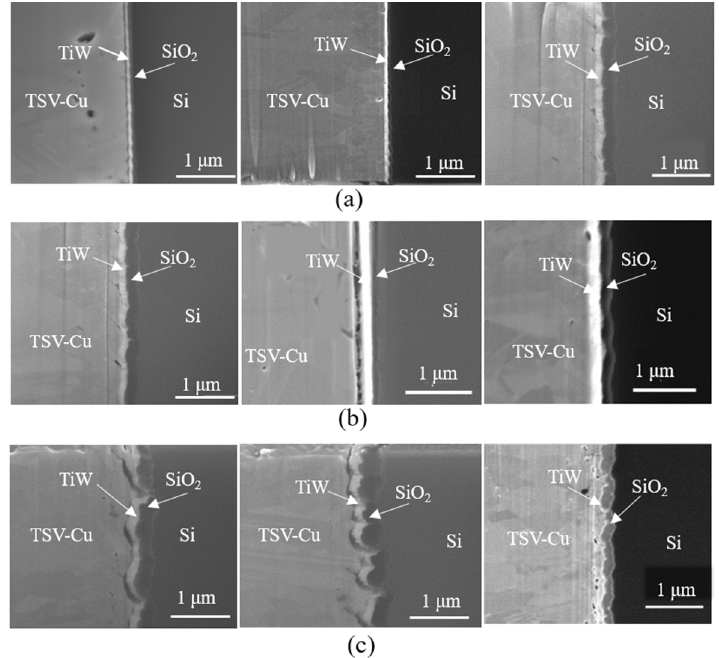
Figure 4. Failure modes of TSV-Cu/TiW/SiO 2 /Si interfaces: ( a ) as fabricated; ( b ) thermal cycling; ( c ) annealing.